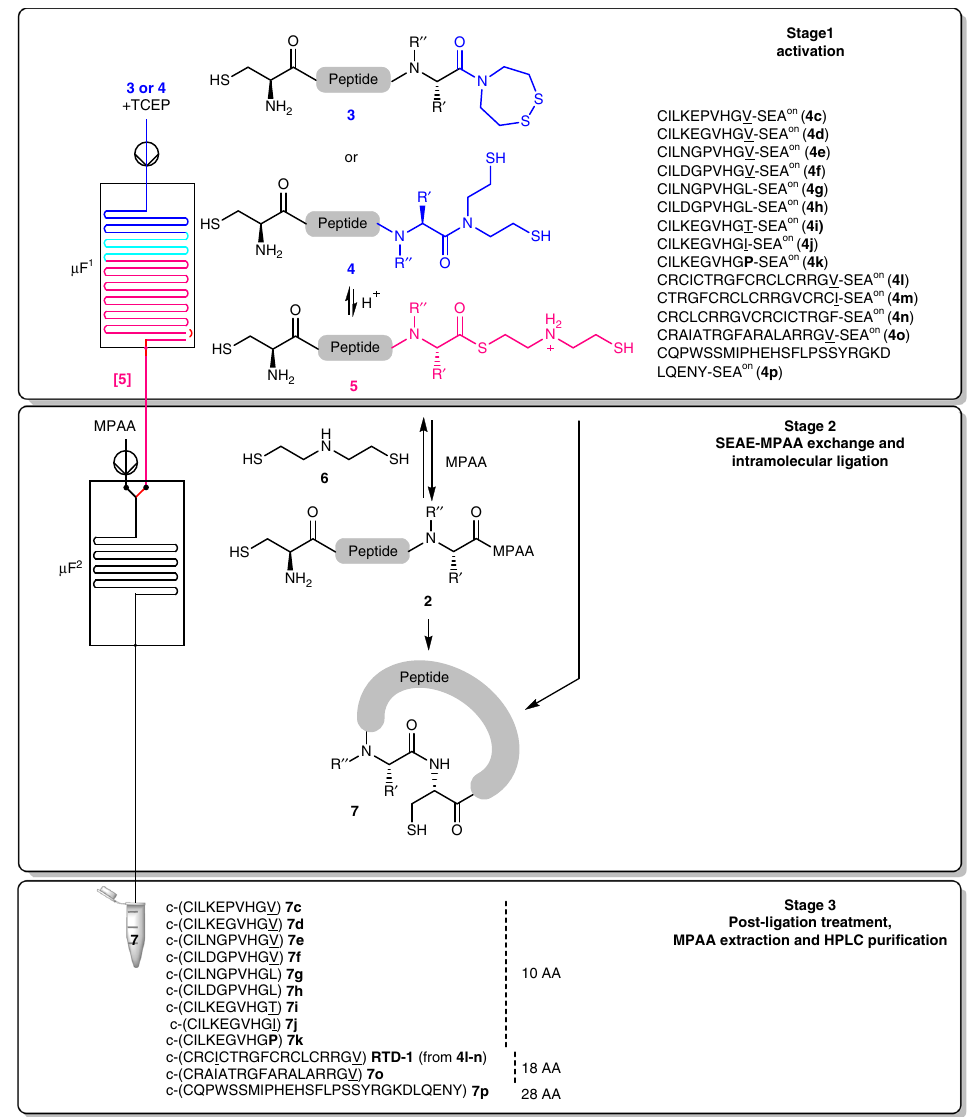
Fig. 3 Fast intramolecular NCL toward macrocyclic peptide constructs. Details of the three-stage (activation – ligation – post ligation treatment) micro fl uidic process allowing intramolecular NCL at non-problematic junctions (Leu (L), R ′ = − CH 2 CH(CH 3 ) 2 , R ′′ = H; Tyr (Y), R ′ = − CH 2 Ph- p -OH, R ′′ = H), dif fi cult junctions (underlined, Val (V): R ′ = − CH(CH 3 ) 2 , R ′′ = H; Thr (T): R ′ = − CH(CH 3 )(OH), R ′′ = H; Ile (I): R ′ = − CH(CH 3 )(CH 2 CH 3 ), R ′′ = H) and intractable proline junction (bold, Pro (P): R ′ = R ′′ = − (CH 2 ) 3 − ). Two micro fl uidic modules ( µ F) are concatenated. In microreactor element µ F 1 (Activation, stage 1), the feed solution containing an inactive and stable peptide precursor, SEA off 3 or SEA on 4 , is thermally rearranged at pH 1 to give reactive SEAE thioester 5 . In microreactor element µ F 2 (SEAE-MPAA exchange and intramolecular ligation, stage 2), reactive SEAE thioester 5 cyclizes directly into peptide 7 or is converted into MPAA thioester 2 which then cyclizes into peptide 7 . Depending on the conditions, amine dithiol 6 can become a competing nucleophile and convert MPAA thioester 2 back to SEA on peptide 4 . The last stage (Post ligation treatment, MPAA extraction and HPLC puri fi cation, stage 3) enables the isolation of the cyclic